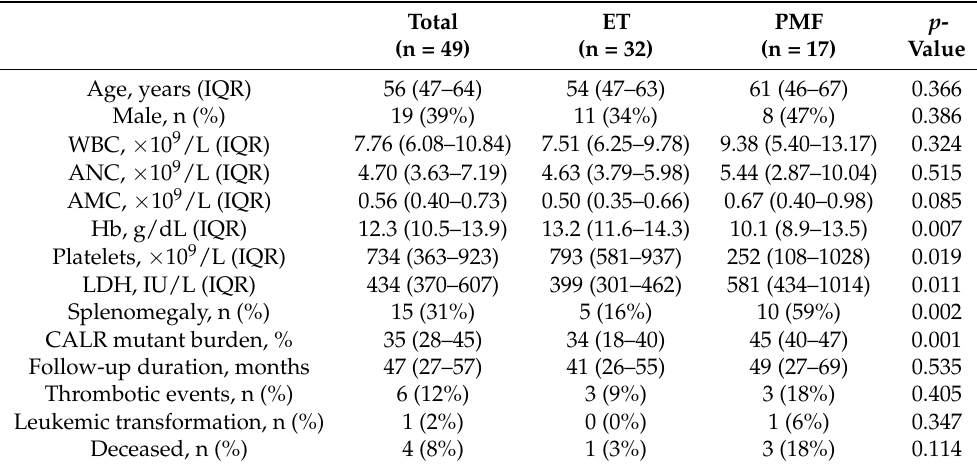
Table 1. Characteristics of patients with CALR mutation.